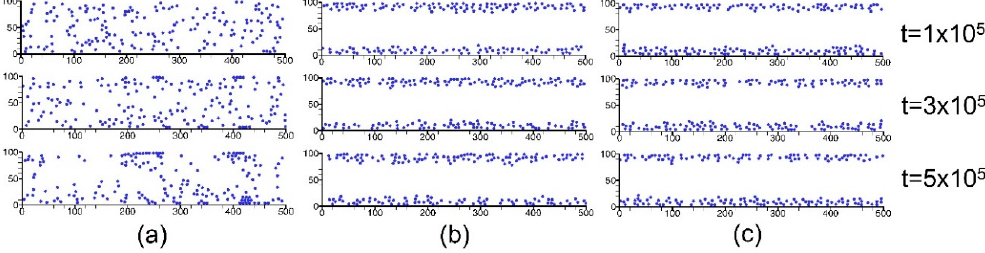
Figure 14. Snapshots of the migration process of particle suspensions with different channel Reynolds numbers, ( a ) Re 0 = 4, ( b ) Re 0 = 40, and ( c ) Re 0 = 100. The particle diameter is d p = 6 and the concentration is ϕ = 10%.